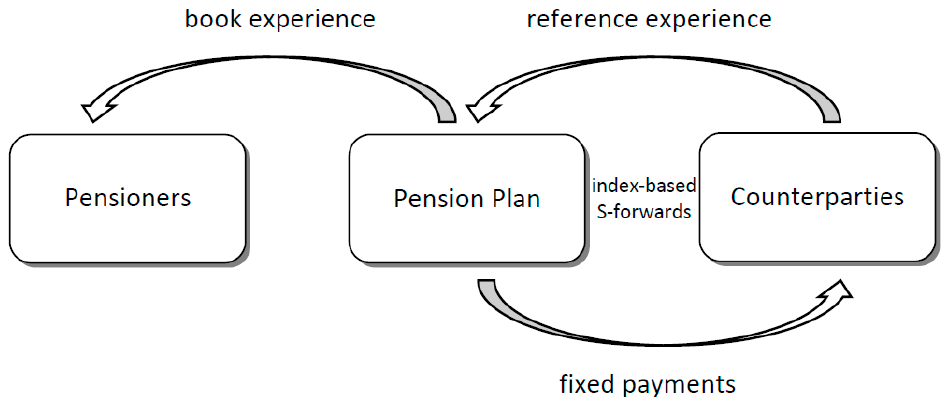
Figure 4. A longevity hedging scheme using index-based S-forwards.